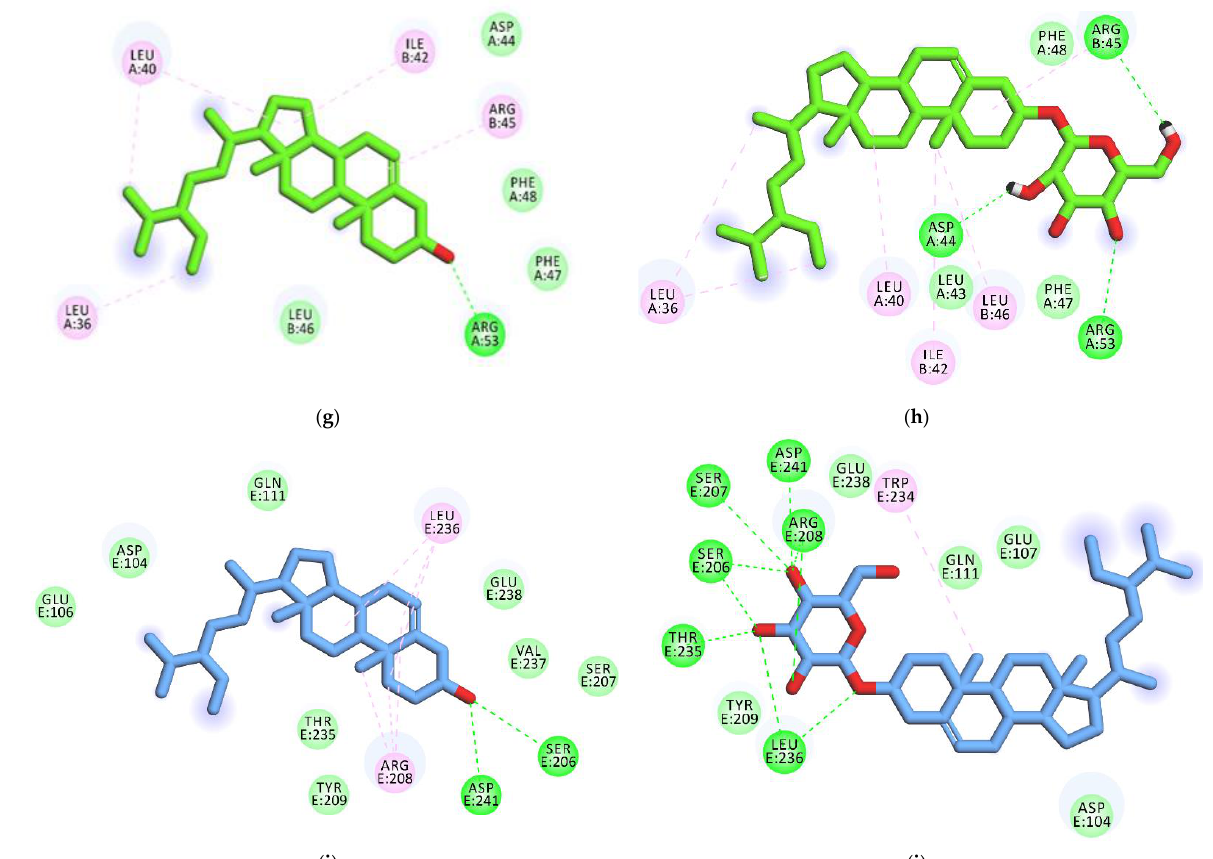
Figure 5. ( a ) Two-dimensional image of 6 ′ -Sialyl- N -acetyllactosamine docked into the active site of influenza A/H1N1 hemagglutinin; ( b ) 2D of β -sitosterol docked into the active site of influenza A/H1N1 hemagglutinin; ( c ) 2D of β -sitosterol-O-glucoside docked into the active site of influenza A/H1N1 hemagglutinin; ( d ) 2D of the cocrystallized ligand (Zanamivir) docked into the active site of influenza A/H1N1 neuraminidase; ( e ) 2D of β -Sitosterol docked into the active site of influenza A/H1N1 neuraminidase; ( f ) 2D of the cocrystallized ligand (Rimantadine) docked into the active site of influenza proton channel M2 protein; ( g ) 2D of β -sitosterol docked into the active site of influenza proton channel M2 protein; ( h ) 2D of β -sitosterol-o-glucoside docked into the active site of influenza proton channel M2 protein; ( i ) 2D of β -sitosterol docked into hemagglutinin head epitope; ( j ) 2D of β -sitosterol-o-glucoside docked into hemagglutinin head epitope.